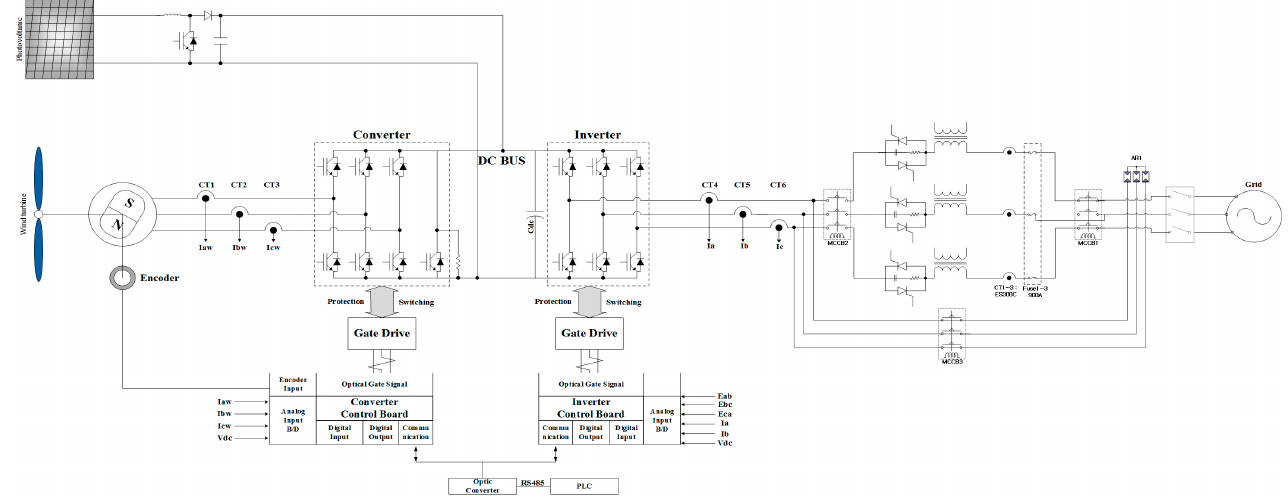
Figure 1. Power conversion system using singular inverter connected photovoltaic and wind turbine generation.